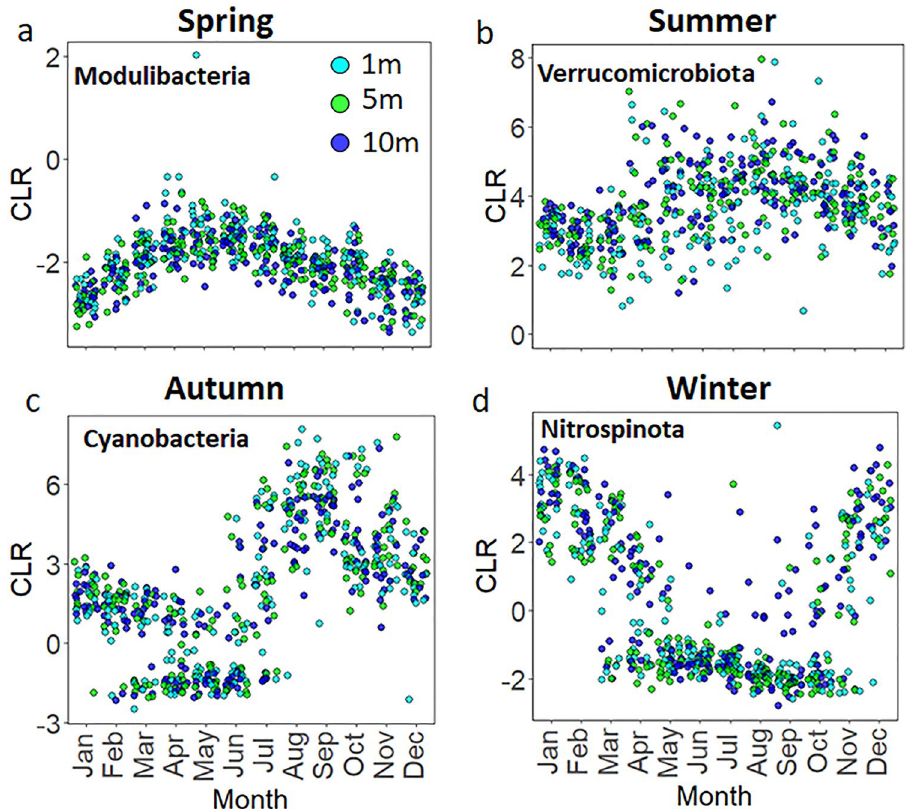
Figure 5. Seasonal changes in bacterial phyla in the euphotic zone (1, 5 and 10 m) in Bedford Basin. Significance patterns and temporal niches were assessed with a permutation test (“multipatt” function from the Indicspecies package 52 ; see Methods and Supplementary Table 9). Due to the compositional nature of the sequence data, the changes are visualized with CLR values rather than relative